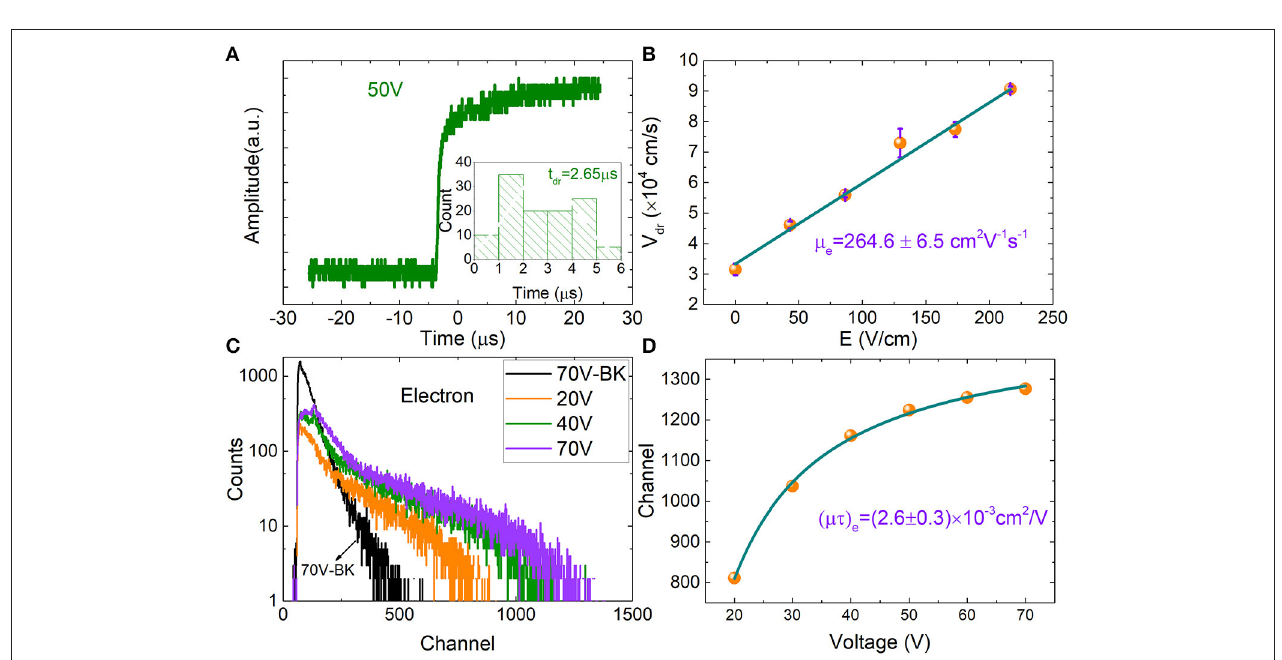
FIGURE 4 | (A) Typical voltage pulses from preamplifier induced by α particles at 50V bias. The distribution of the pulse rise time (10–90%) under 50V bias for electrons. (B) Electron drift velocity as a function of electrical field strength. (C) α Particle pulse height spectra for the MPB:I detector incident on the cathode. (D) Fitted using the single-carrier Hecht equation, the electron mobility lifetime product ( µτ ) e of MPB:I detector was obtained.